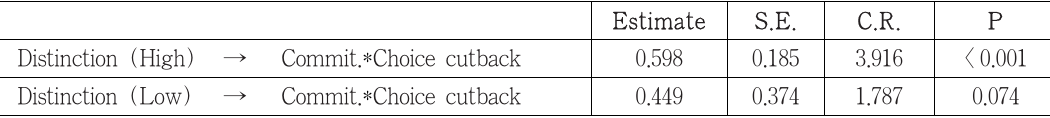
<Table 7> Moderation test for Distinction